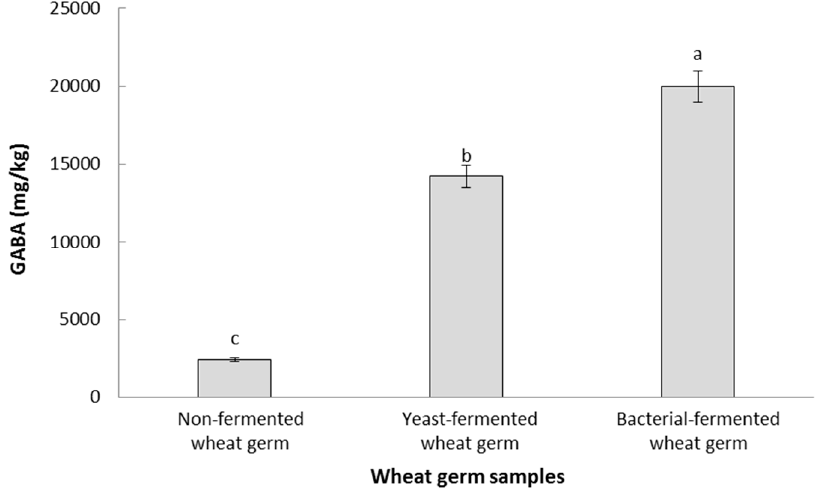
Figure 2. GABA contents (mg GABA/kg freeze-dried sample) in raw and fermented wheat germ samples. Data are expressed as average ± standard deviation. Different letters indicate statistical differences ( p < 0.05) in the GABA contents between the different wheat germ samples.